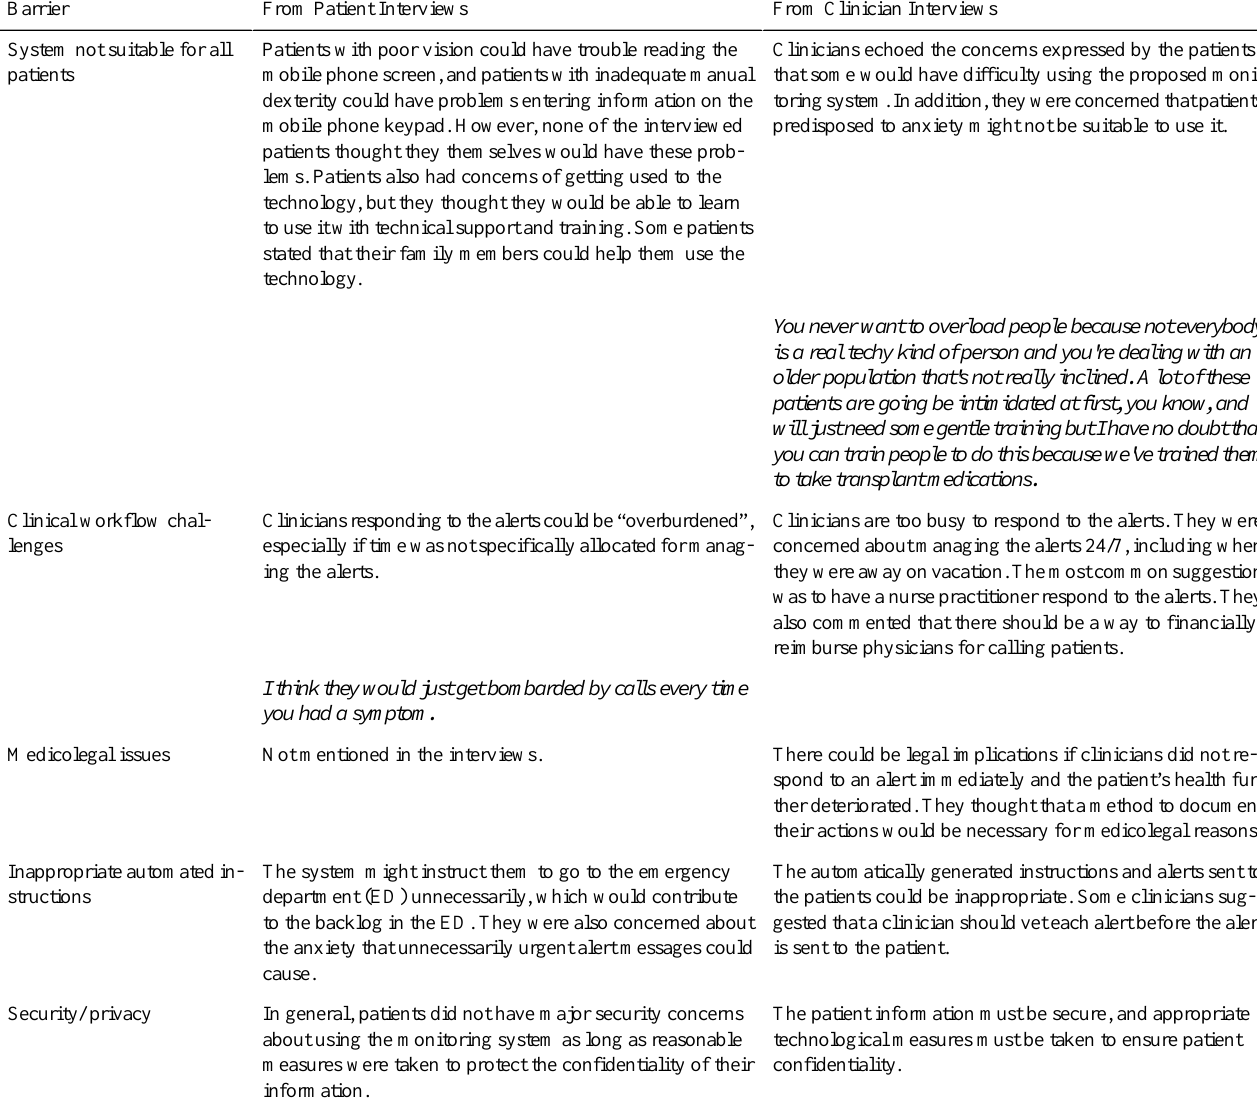
Table 4. Perceived barriers by patients and clinicians (quotes in italics)